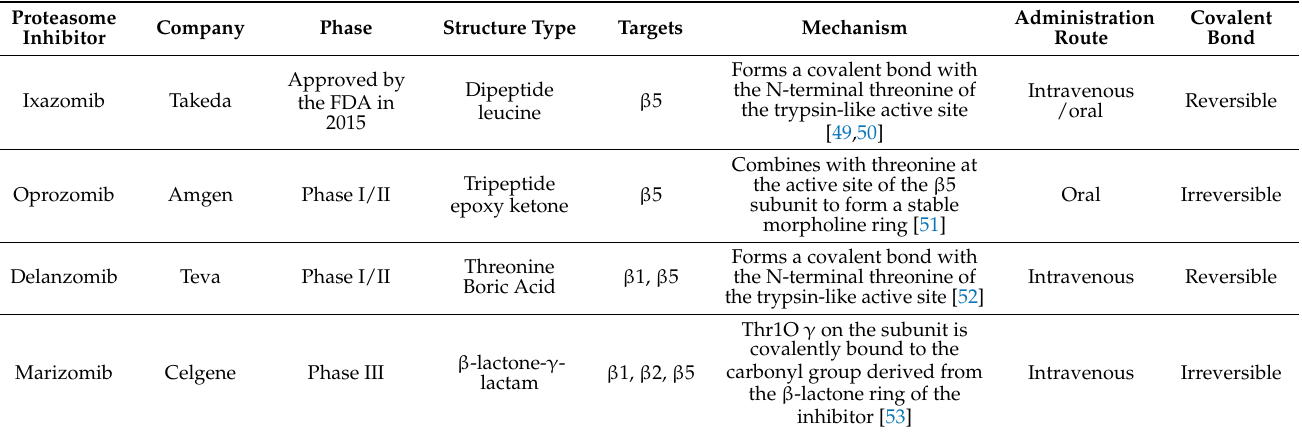
Table 1. Proteasome inhibitors that are approved or currently investigated in clinical trials.